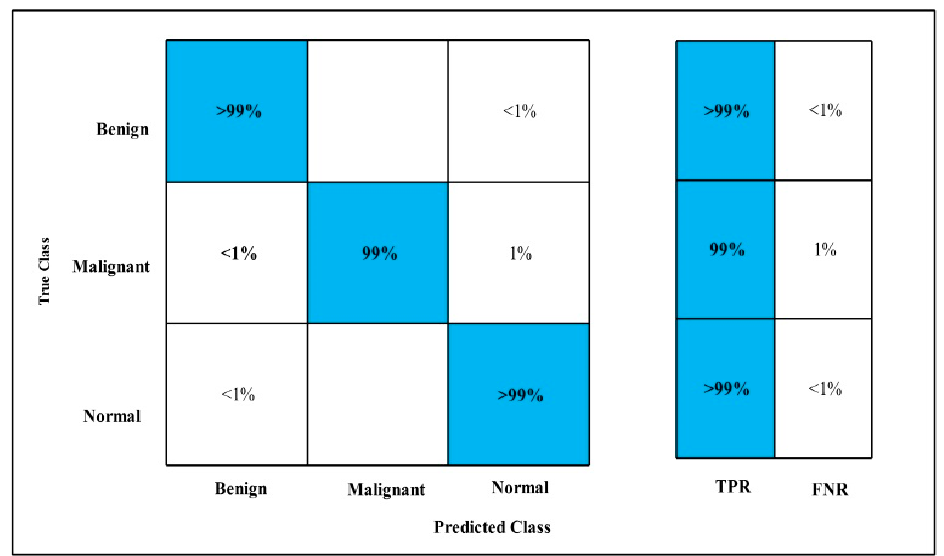
Figure 19. MEWOA on fusion TPR MIAS.